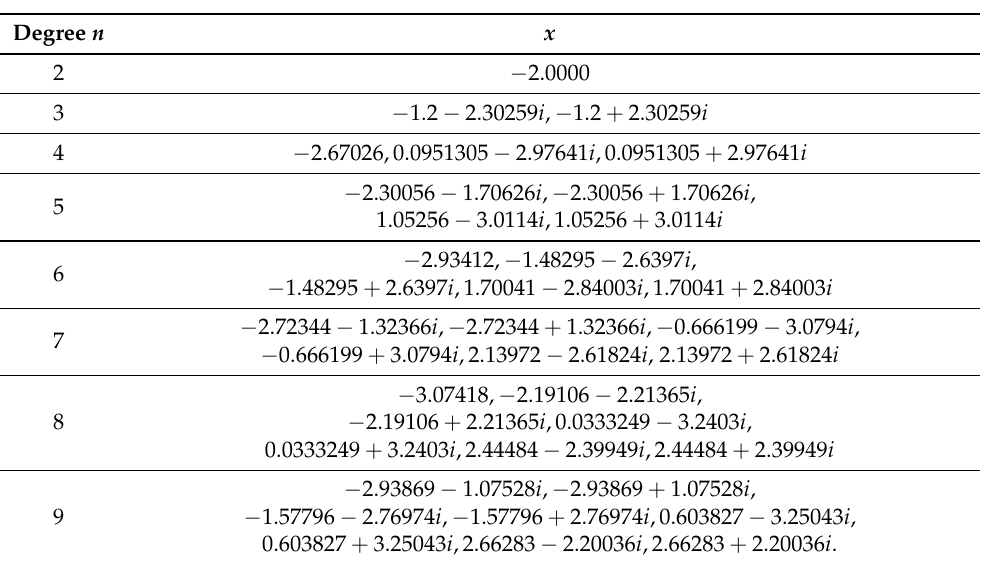
(cid:16) (cid:17) ( S ) = 0. x ,3;2 : 1 , 1 n 2 10